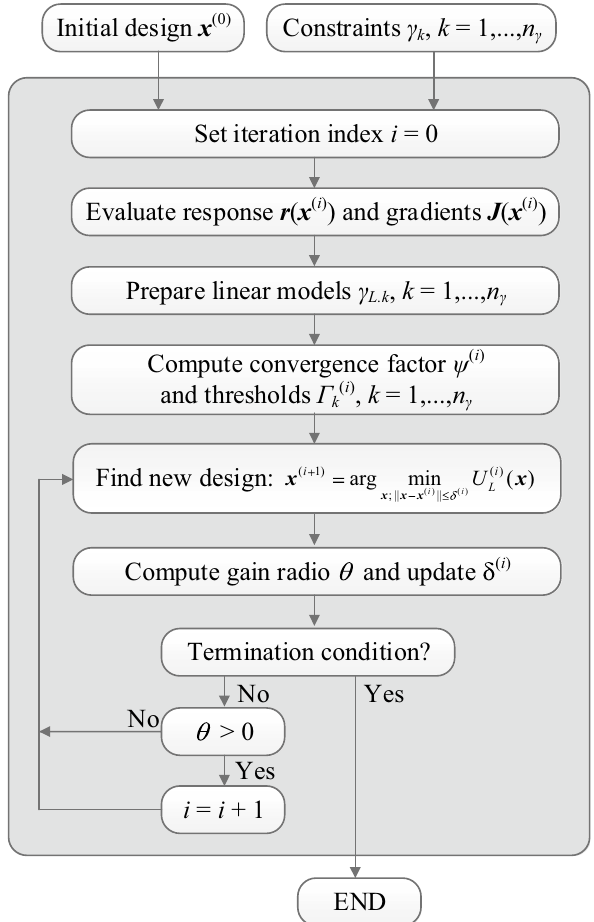
Figure 2. Flow diagram of the proposed size reduction algorithm with explicit constraint